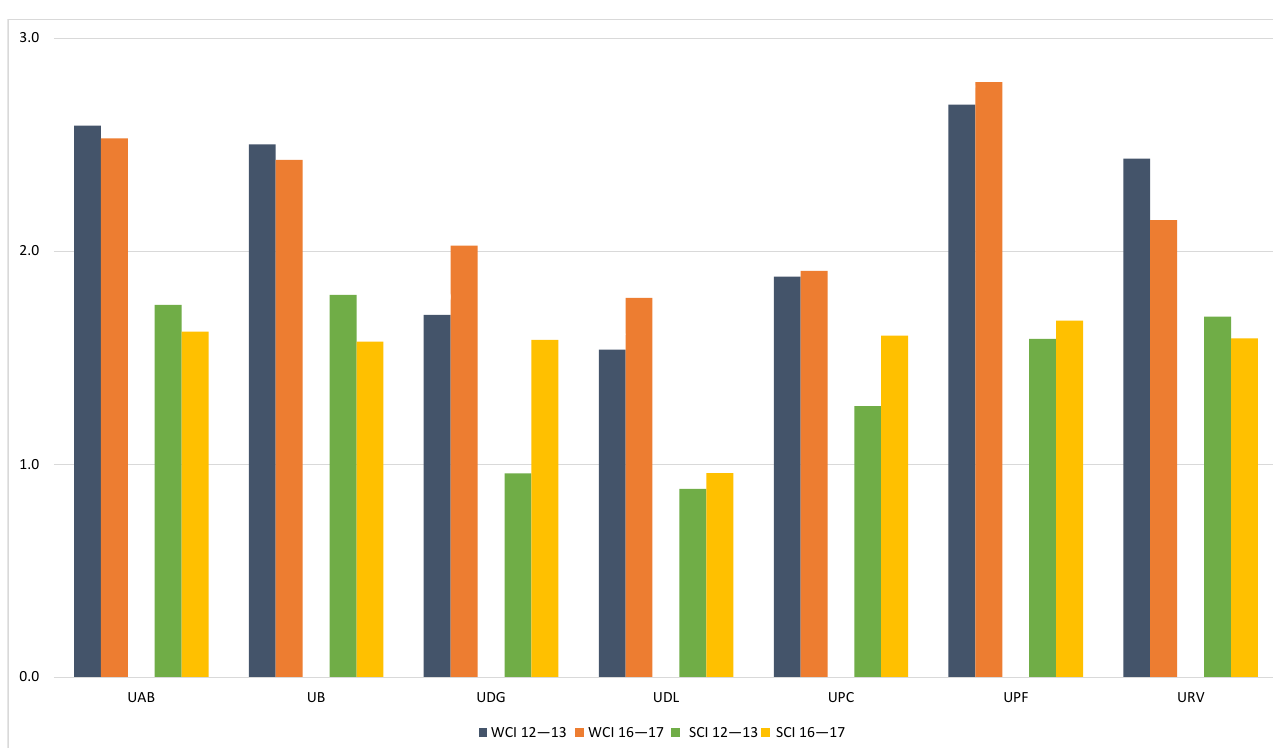
Figure 7. Evolution in the research mission of the Catalan public university system from 2012–2013 to